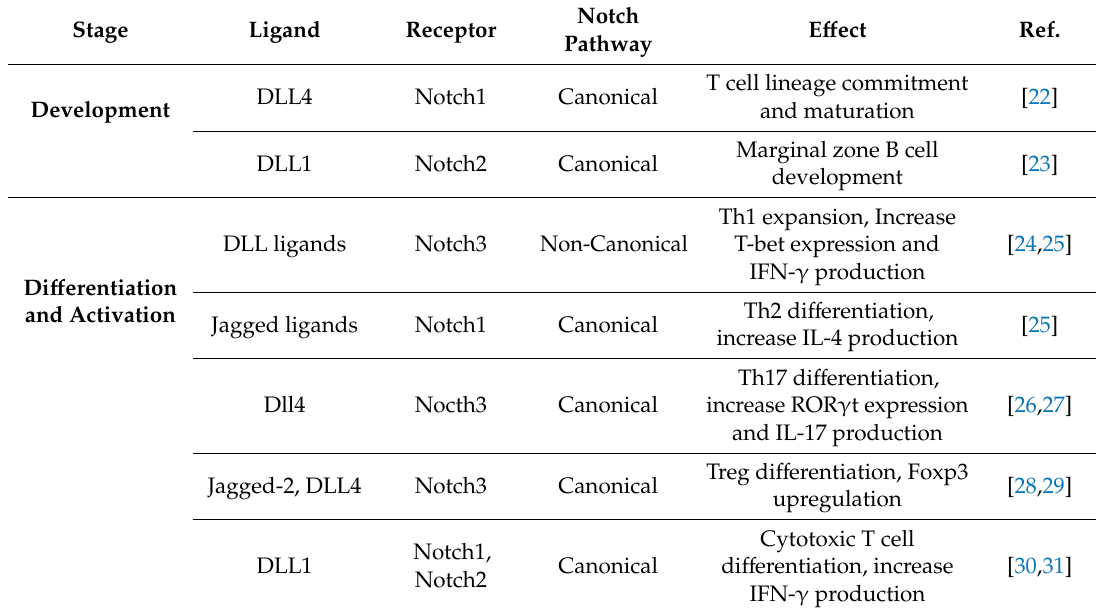
Table 1. Key findings about the role of Notch signaling in lymphocyte development, di ff erentiation, and